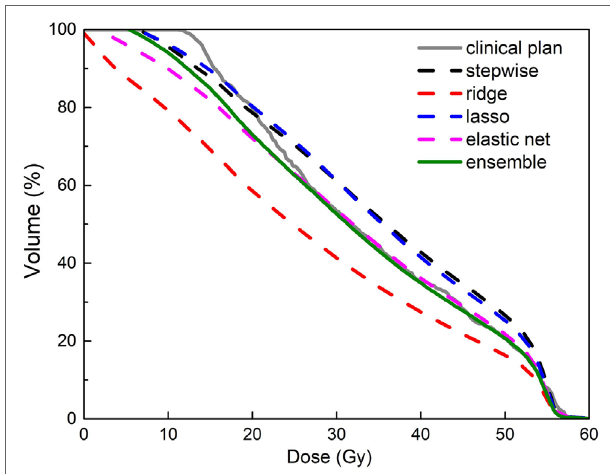
FigUre 8 | An example of improved accuracy of the ensemble model (green solid line) in predicting a bladder dose volume histogram (DVH) for a prostate plan over individual models (dashed lines in other colors). All models were trained with data that include dosimetric outliers (see Robustness to Dosimetric Outliers). The clinical plan DVH (gray solid line) is the “ground truth.” Note that the green line follows the gray line most